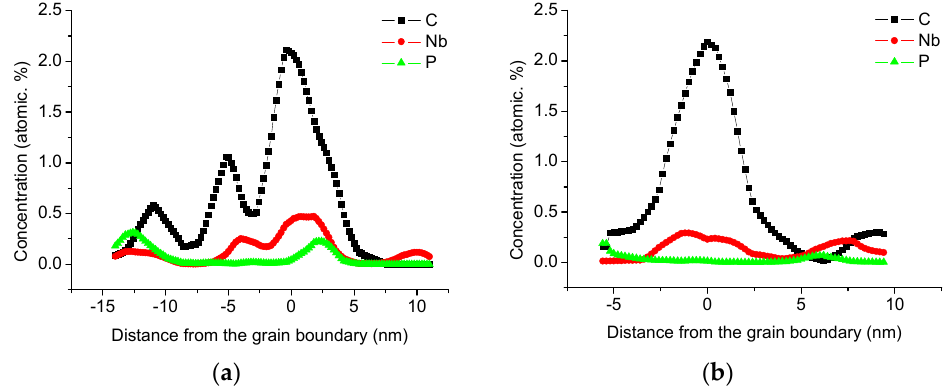
Figure 5. Concentration profiles along the direction perpendicular to the boundary, ( a ) sample 1, ( b ) sample